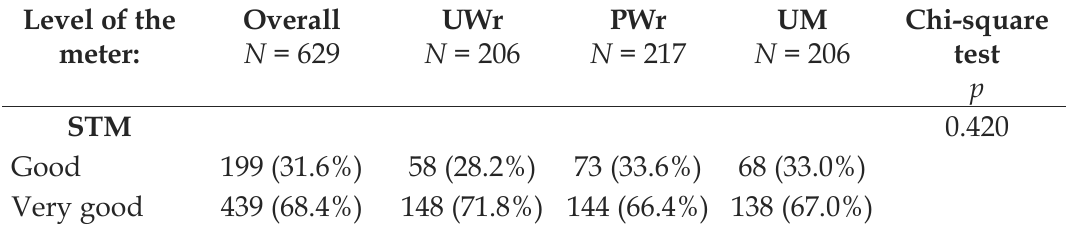
Basic statistics (numbers and proportions) of students differing in the level of STM Level of the Overall meter: N =